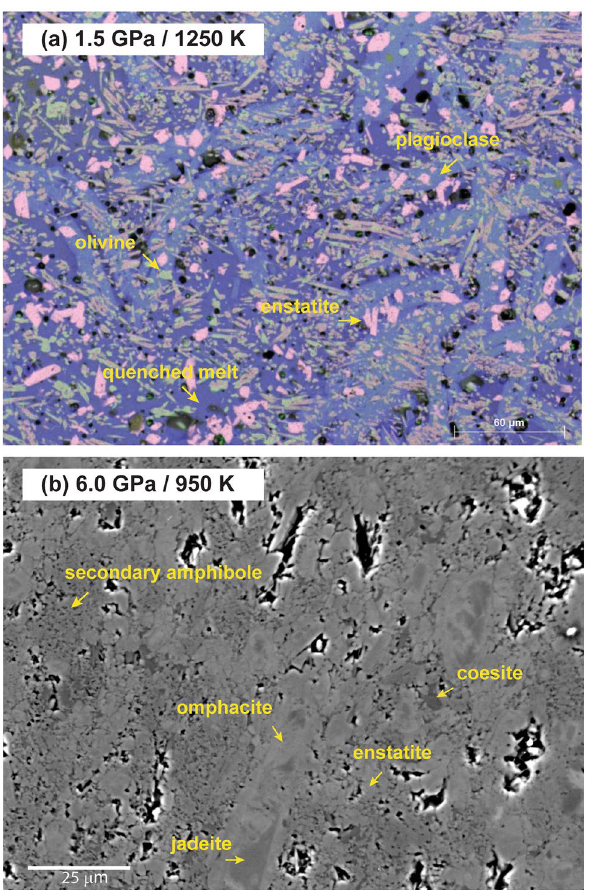
Figure 3. Back-scattered electrons (BSE) image of the recovered sample after the electrical conductivity measurements. ( a ) Energy-dispersive X-ray spectroscopy (EDS) compositional map overlapped with a back- scattered electrons (BSE) image of the recovered sample at 1.5 GPa. The phases present in the sample are olivine (green), enstatite (pink), plagioclase (light blue), and melt (indigo). ( b ) The BSE image showing the glaucophane starting sample recovered after electrical conductivity measurements at 6